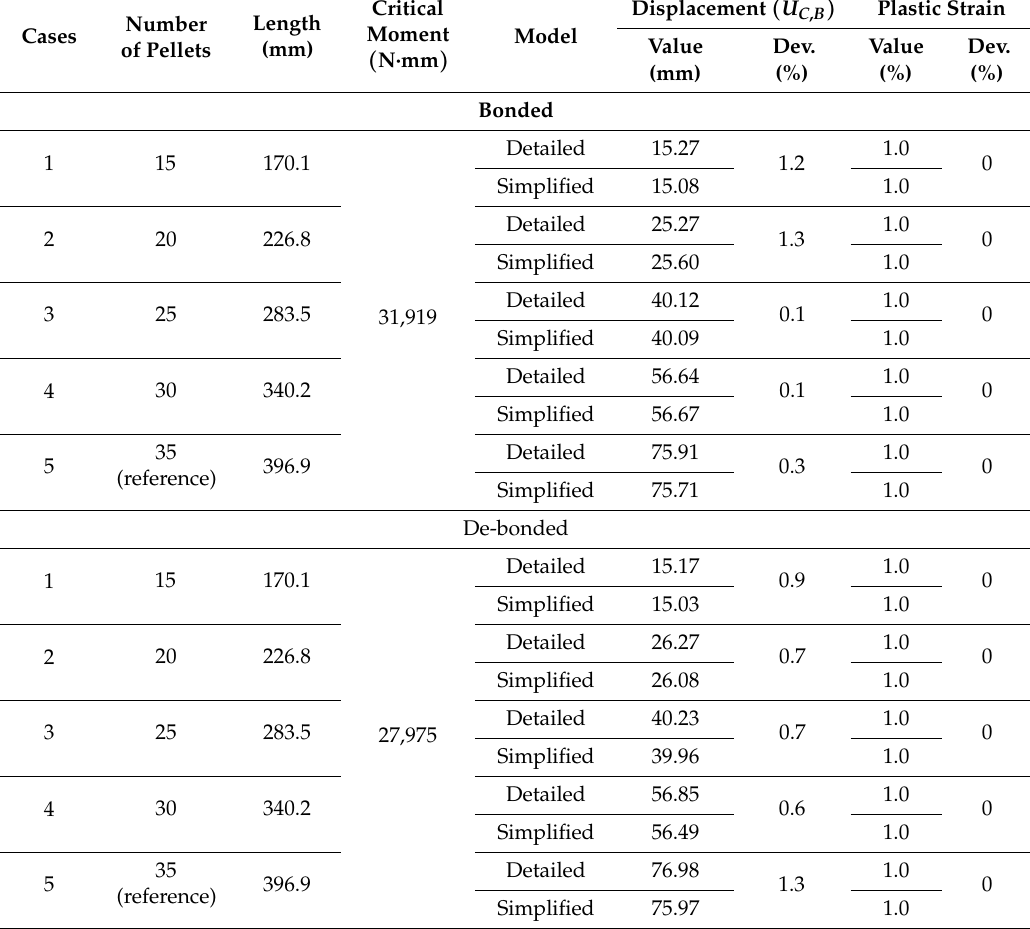
Figure 11. Comparison of the moment-curvature diagrams of the detailed model and simplified model. Table 5. Application of the calibrated beam parameters to di ff erent lengths of fuel rod segments.